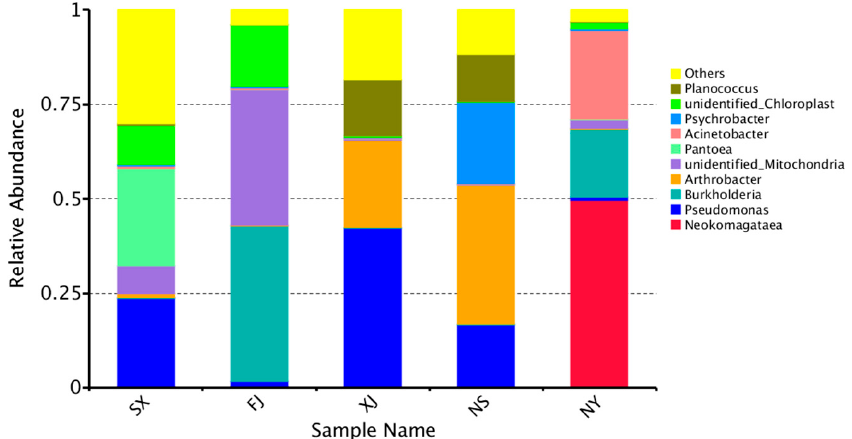
Figure 5. Venn graphs of the five P. sinese samples. The numbers inside the diagram indicate the numbers of OTUs. 3.2. Alpha Diversity Analysis The trend of rarefaction curves suggested that there was sufficient sampling of the microbial communities and indicated that each sample was different (Figure 6). Good’s coverage estimator values ranged from 99.9% to 100% (Table 3), indicating that the sequence numbers per sample were high enough to capture the majority of the 16S rRNA gene sequences to show bacterial diversity.